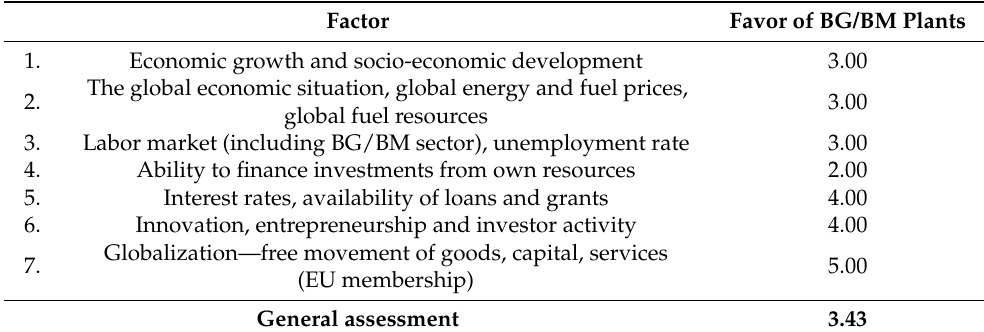
Table 5. Economic environment of BG/BM plants in Poland in the context of their development